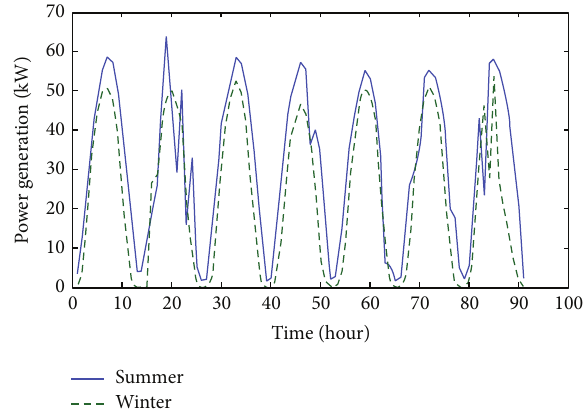
Figure 3: PV power generation curves at Taichung Thermal Power Plant in different seasons.